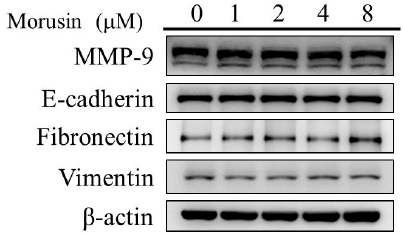
Figure A1. Screening of the inhibitory effects of morusin on multiple protease expressions in NPC-39 cells. Total cell lysates were prepared for determining the levels of MMP-9, E-cadherin, fibronectin, and vimentin protein.